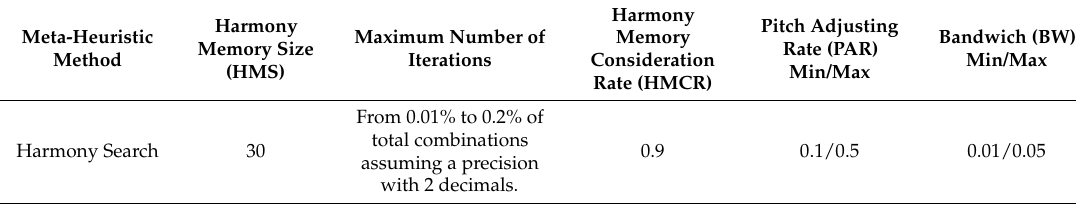
Table 2. Several configuration parameters of the harmony search method.